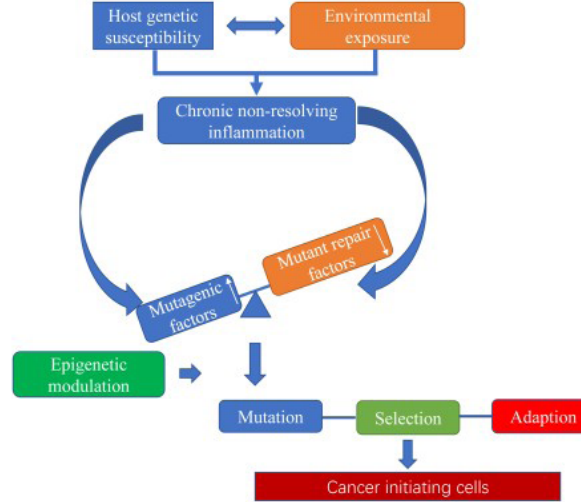
Figure 2. Basic framework of Cancer